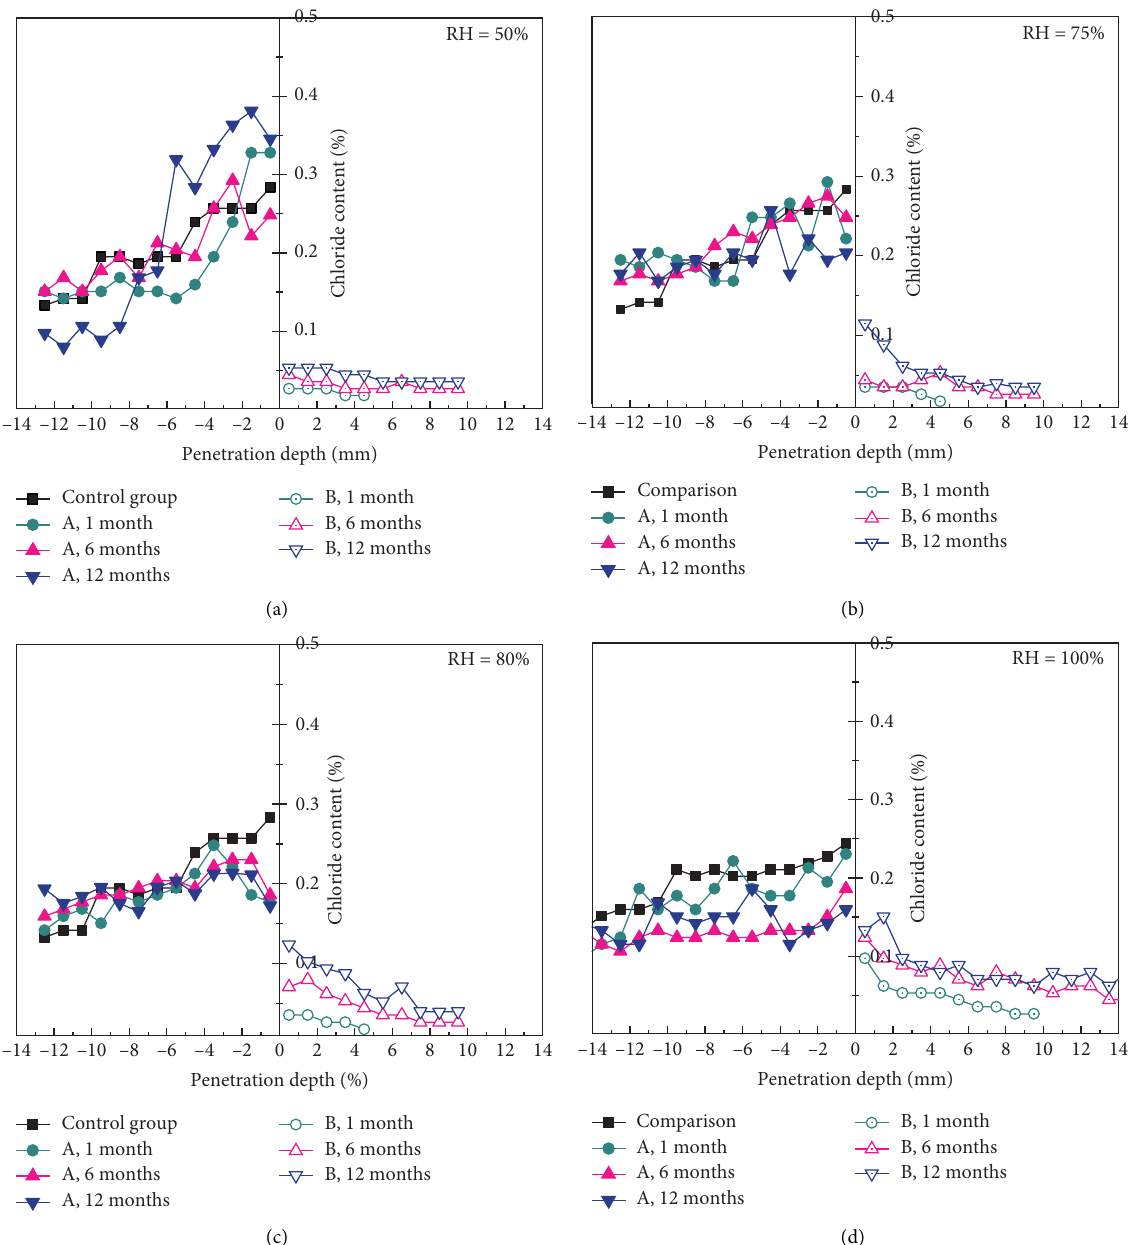
Figure 4: Chloride content curves of concrete with various internal RH (w/c � 0.5). (a) RH � 50%, (b) RH � 75%, (c) RH � 80%, (d) RH � 100%. Control group represents that the chloride content was immediately determined after the chloride attack test. The A specimen was initially saturated with NaCl solution; the B specimen was initially saturated with water; 1, 6, and 12 months were the connecting duration for A and B